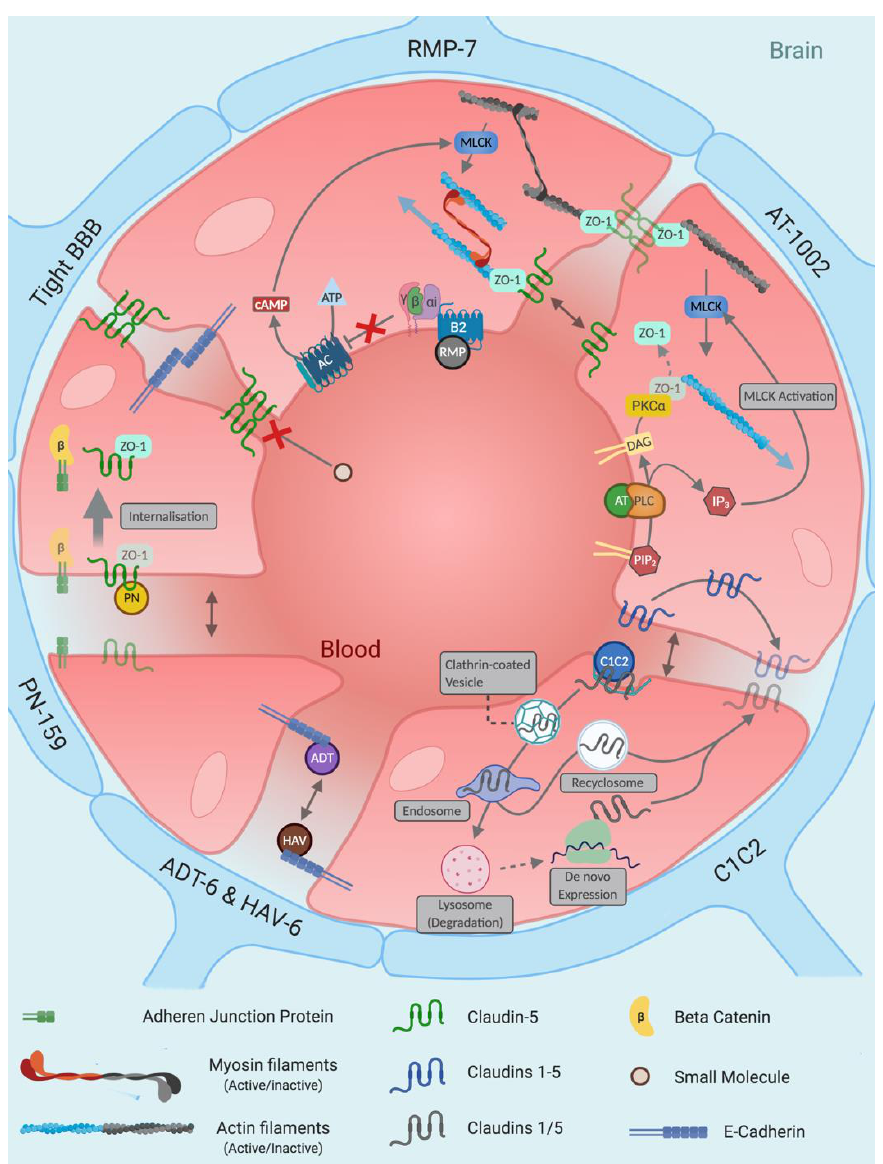
Figure 5. Mechanism summary for blood–brain barrier-modulating peptides. Similar to small mol- ecule blood–brain barrier modulators, peptides affect tight junction integrity in a diverse manner, either through direct interruption of TJ protein trans interactions or by altering an indirect down- stream effector. Abbreviations: α i (Gi alpha GPCR subunit), AC (adenylate cyclase), ADT (ADT-6 or ADTC5), AT (AT-1002), ATP (adenosine triphosphate), ß (beta GPCR subunit), B2